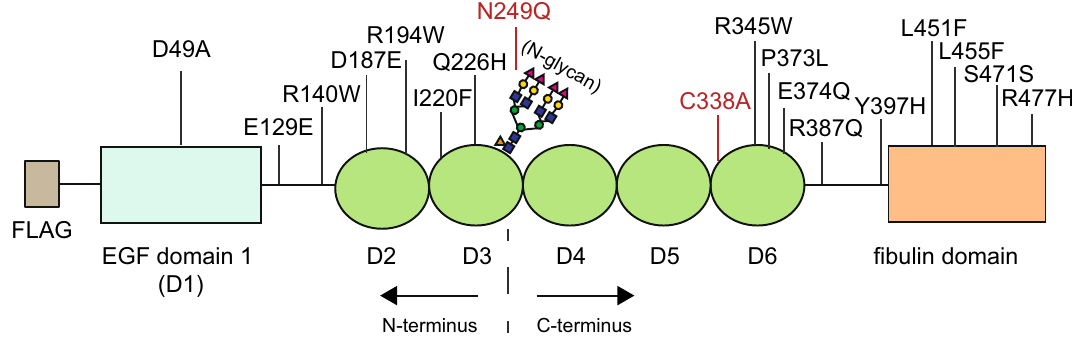
Figure 1. Schematic of clinically-identified F3 variants with respect to localization of F3